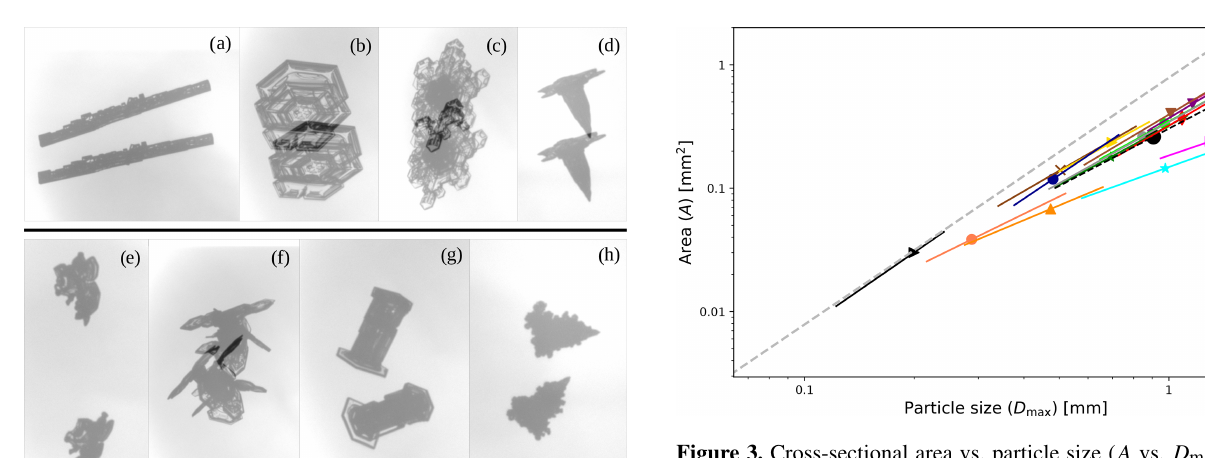
Figure 3. Cross-sectional area vs. particle size ( A vs. D max ) rela- tionships are shown in logarithmic scale for all the shape groups (solid lines) and all data (dashed black line). The median D max of the data is represented as a single point on each line. The length of the fit lines is defined by 16th and 84th percentiles of D max . For a legend of the shape groups, see Fig. 5. For comparison, the cross- sectional area of spheres given by (π/ 4 ) · D 2 max is shown as a dashed gray